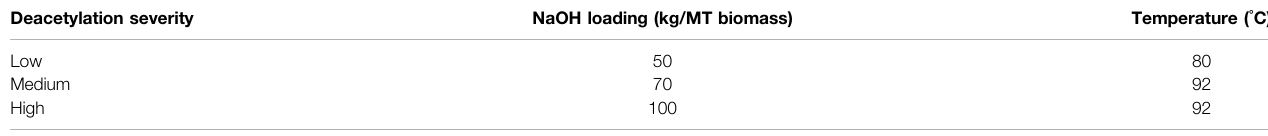
(cid:129) ” indicates